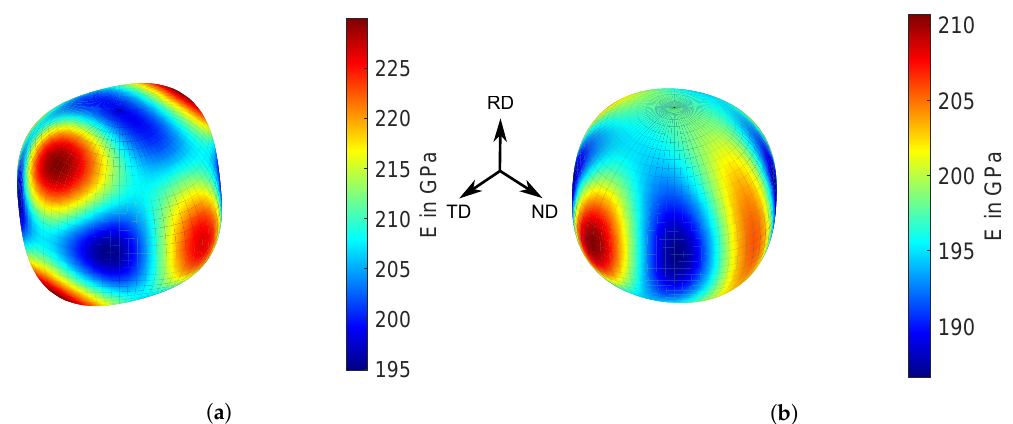
Figure 3. Young’s modulus distribution E of the textured phases. ( a ) Ferrite and ( b ) austenite.